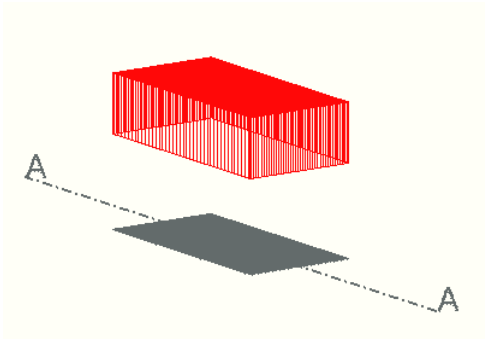
Figure 11: Uniform load distribution over a rectangular tire-ground contact area (the A-A vertical section is taken along the cross- section of the wheel).